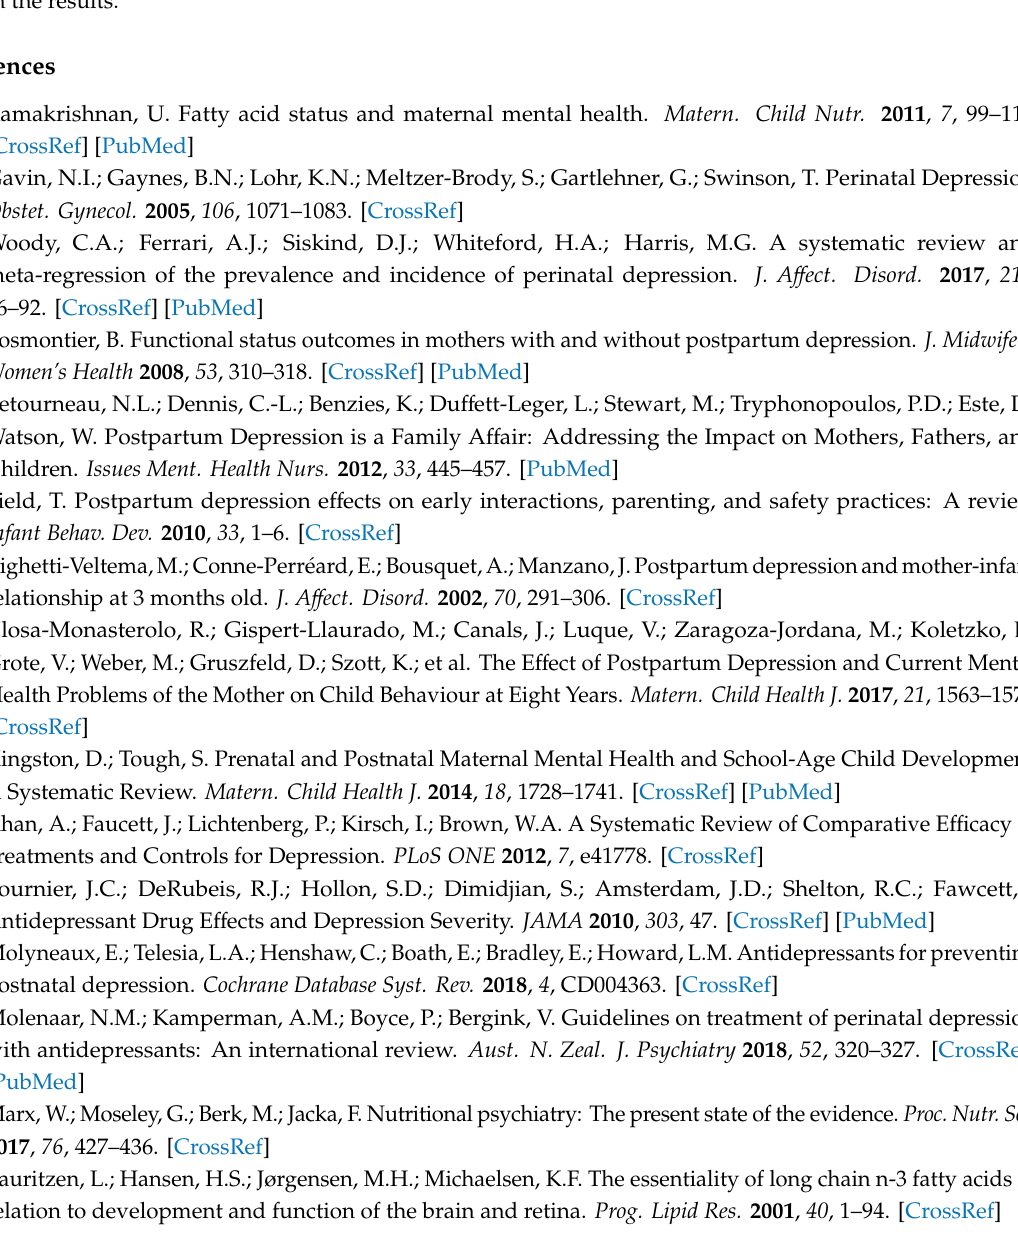
Table S1: Smoking status, alcohol consumption and breastfeeding status of the women ( n = 71), Table S2: Comparison of the characteristics of the enrolled women ( n = 71) with the women who declined to participate ( n = 18), Table S3: Comparison of PUFA composition (% of total RBC phospholipid FA) from the women who reported favourable dietary practices regarding n-3 PUFA intake ( n = 29) with those who did not ( n =